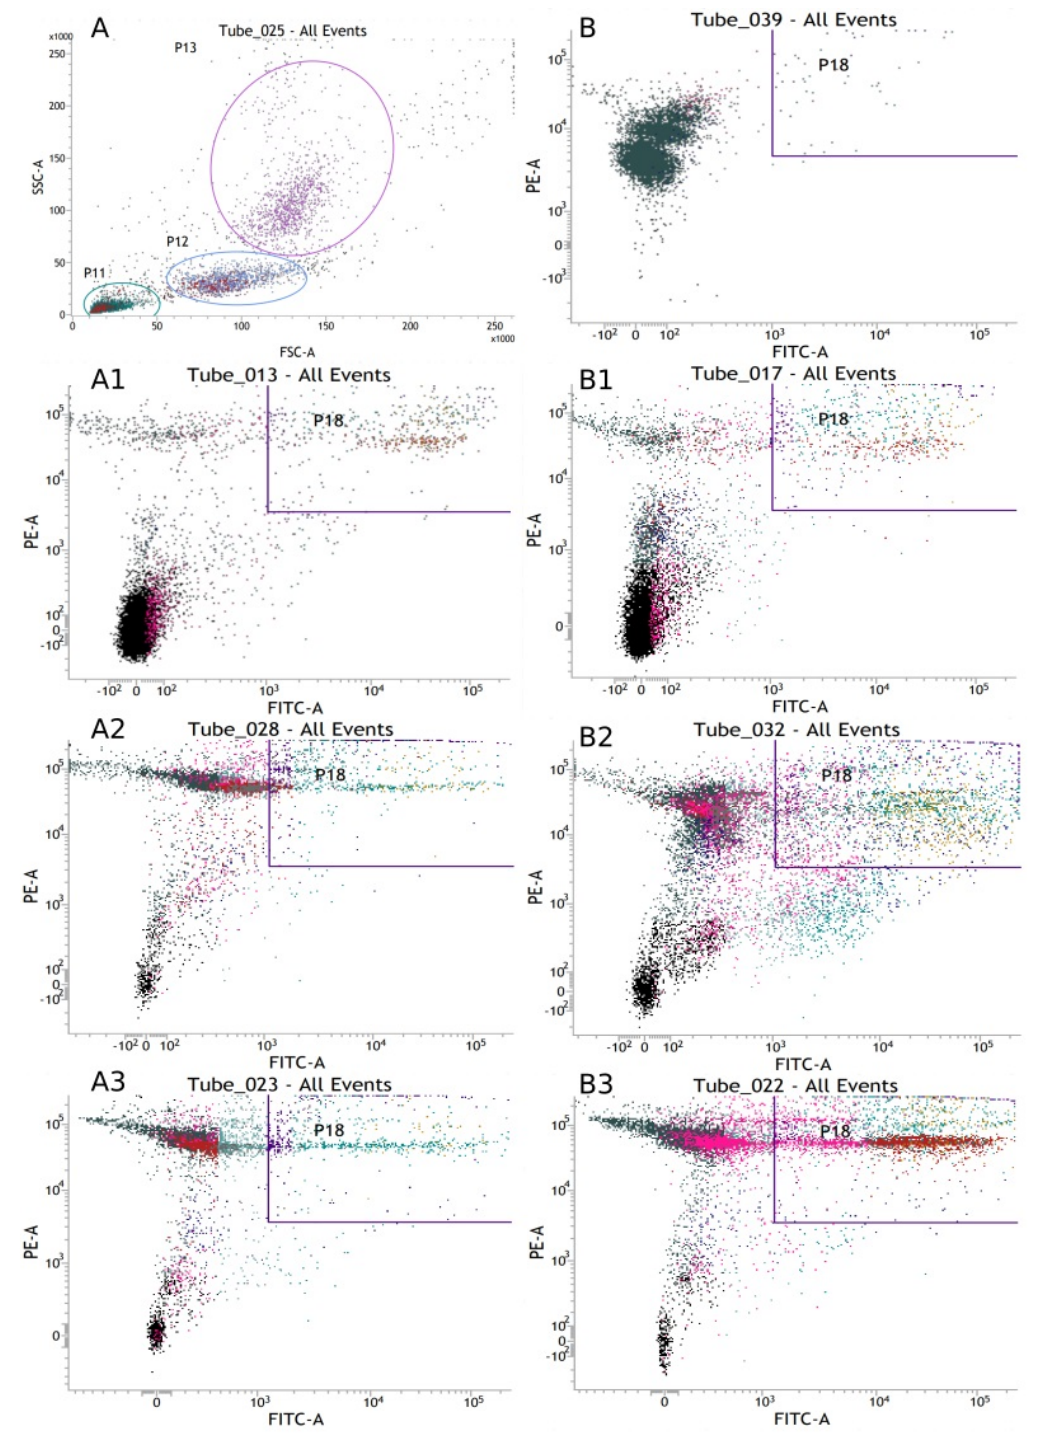
Figure 3. Flow cytometric analysis of phagocytosis in blood of pigs (dot plots). ( A )—pig white blood cells—lymphocytes (P11), monocytes (P12), and granulocytes (P13), ( B )—phagocytosis-negative control; ( A1 )—phagocytic cells in pigs at 28 days of age in control group; ( A2 )—phagocytic cells in pigs at 70 days of age in control group; ( A3 )—phagocytic cells in pigs at 160 days of age in control group; ( B1 )—phagocytic cells in pigs at 28 days of age in the experimental group; ( B2 )—phagocytic cells in pigs at 70 days of age in experimental group; ( B3 )—phagocytic cells in pigs at 160 days of age in experimental group; P18—gate containing cells phagocytizing E. coli labeled with FITC (fluorescein